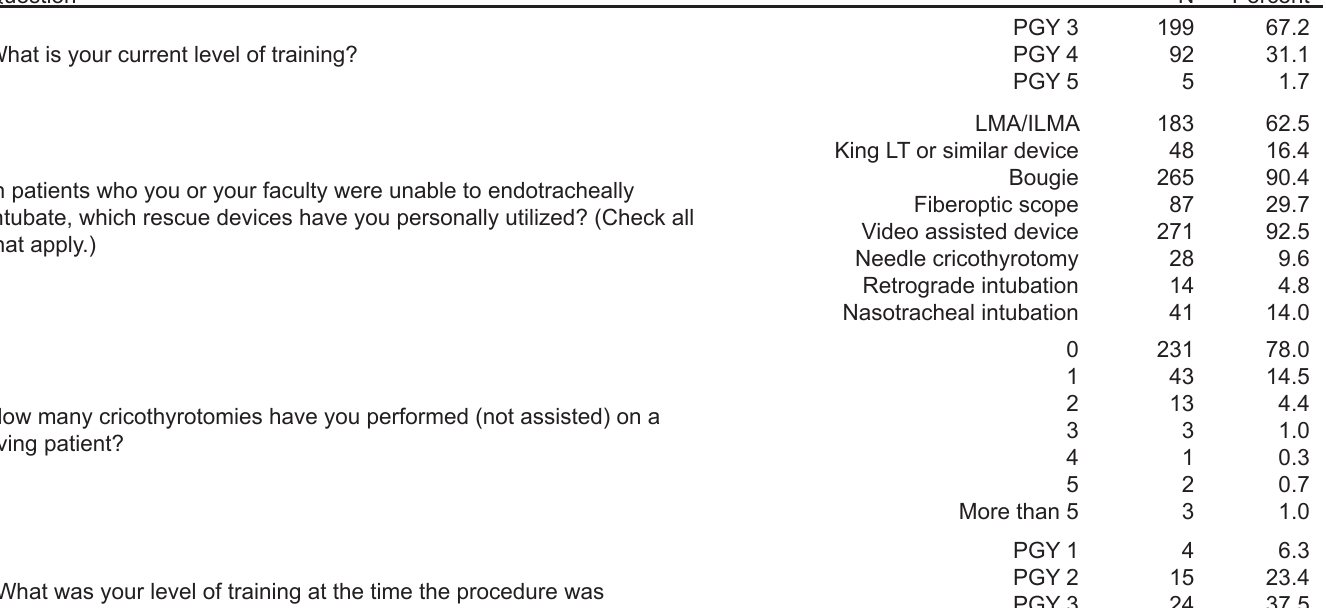
Table 1. Responses to selected survey questions related to performance of cricothyrotomy in the emergency department. Question N What is your current level of